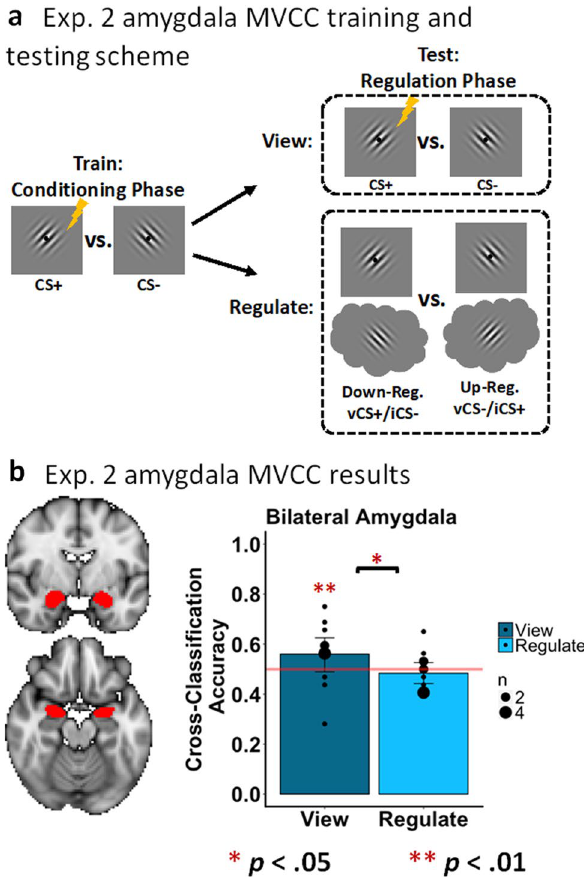
Figure 6. MVCC in the amygdala during the emotion regulation phase (experiment 2). ( a ) A graphical representation of the MVCC training and testing scheme. The lightning bolt denotes the CS+. ( b ) Results of the MVCC classification of view trials (vCS+ vs. vCS−; dark-gray bars) and regulate conditions (‘down-regulate’ (vCS+/iCS−) vs. ‘up-regulate’ (vCS−/iCS+); light-gray bars) in bilateral amygdala. The horizontal line represents chance (50%), and the black dots represent how many participants had a given classifier